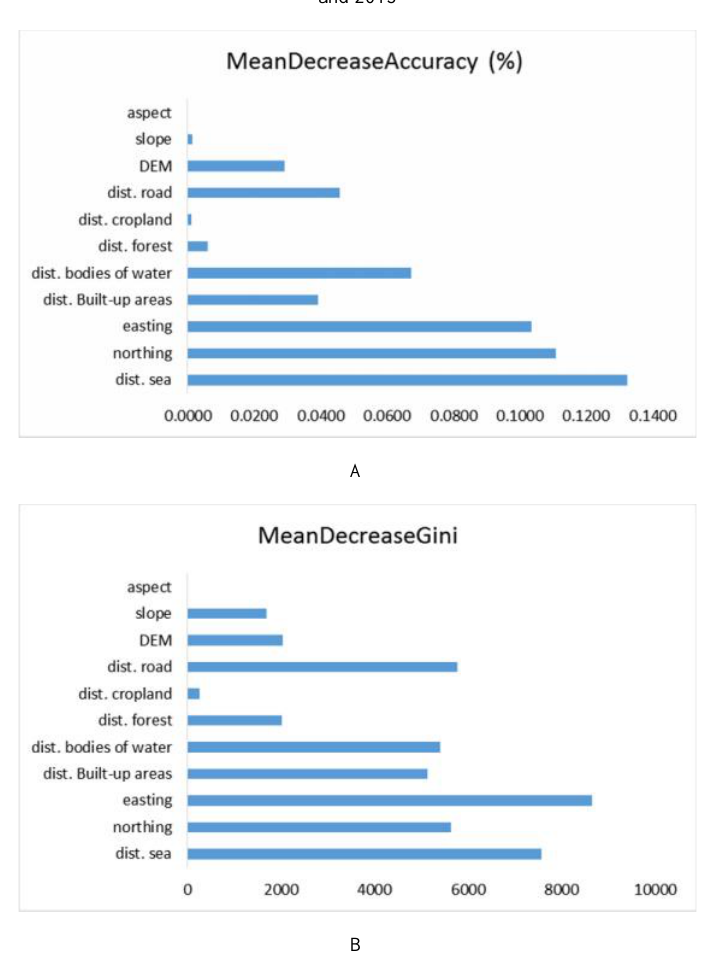
Figure 6. Variable importance plots based on A) mean decrease accuracy and B) mean decrease Gini for urban growth prediction which had the highest proportion of variance